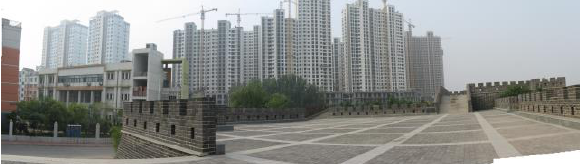
Figure 18. The current situation of Tucheng ruins II